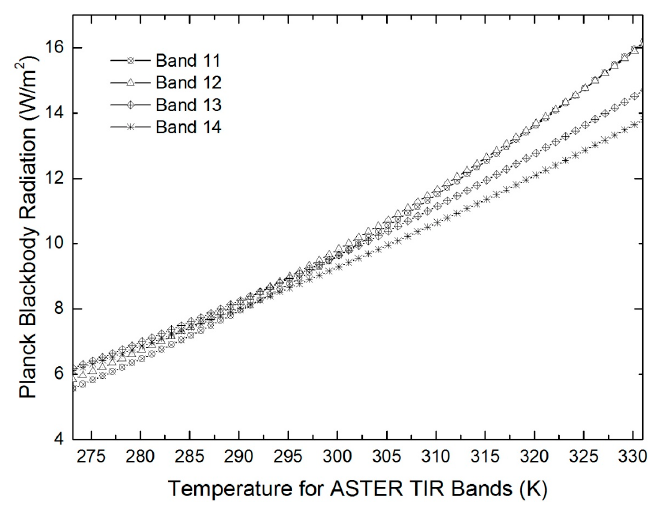
Figure 8. The relationship between the Planck blackbody radiation and temperature for ASTER thermal infrared bands. Table 2. The linear fitting coefficients of Planck function for ASTER thermal infrared bands 1 . Band (cid:2183) (cid:2779)(cid:2245) (cid:2184) (cid:2779)(cid:2245)